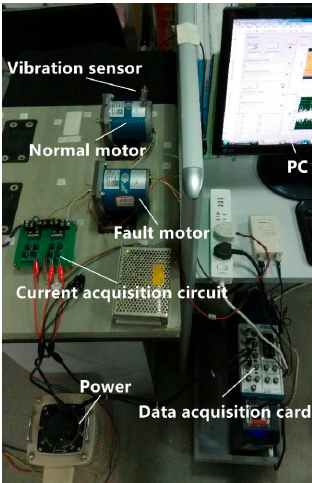
Figure 1. The experimental platform for fault diagnosis of permanent magnet synchronous motors (PMSM).